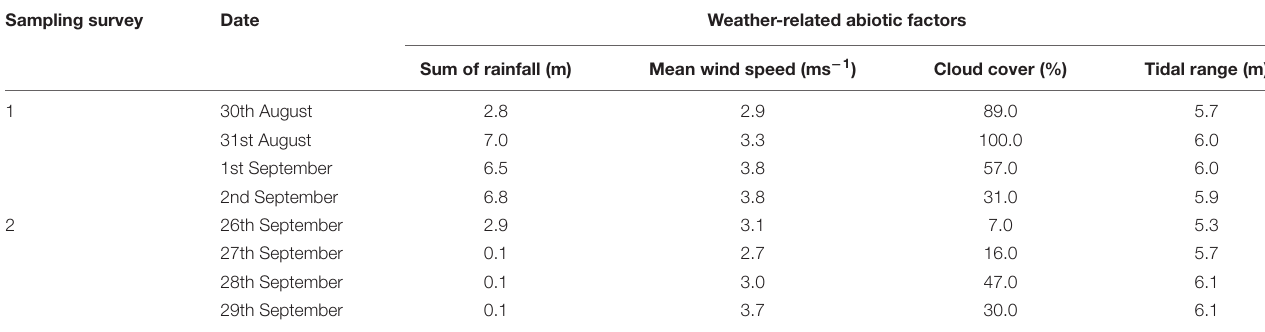
Sampling survey